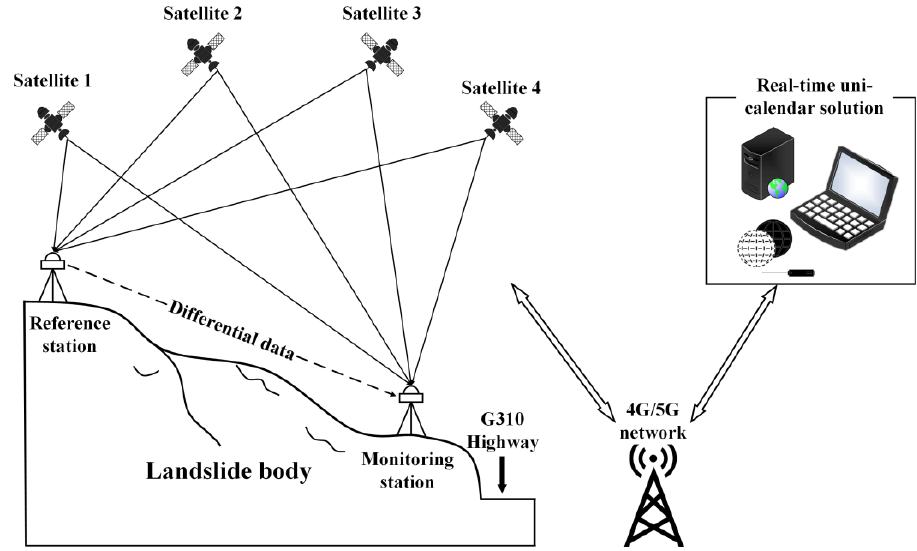
Figure 2. GNSS — real-time kinematic (RTK) landslide deformation monitoring technology. Figure 2. GNSS—real-time kinematic (RTK) landslide deformation monitoring